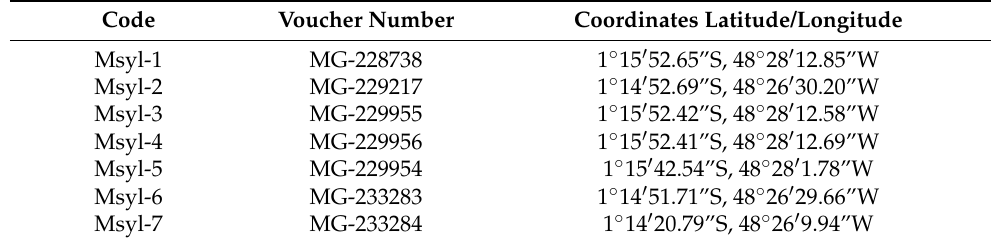
Table 2. Collection site, herbarium voucher number, and geographic coordinates for the Myrcia sylvatica